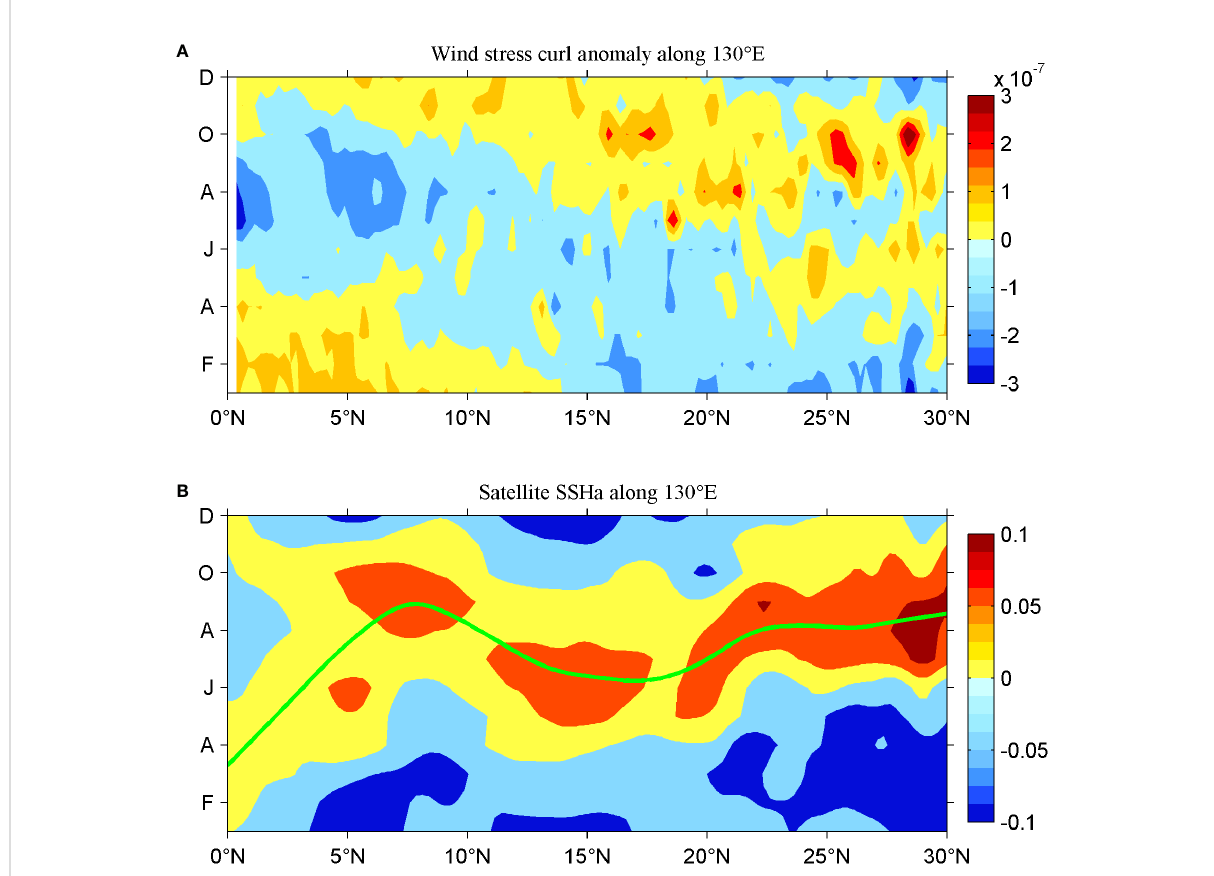
FIGURE 9 (A) Latitude – time diagram of seasonal wind stress curl anomaly along 130°E based on QuikSCAT products (1999 – 2009) (units are 10 − 7 N m − 3 ), and (B) latitude – time diagram of seasonal SSHa from satellite data (1993 – 2019) along 130°E (units are m). The green line denotes the maximum SSHa in the continuous positive belt of the SSHa in